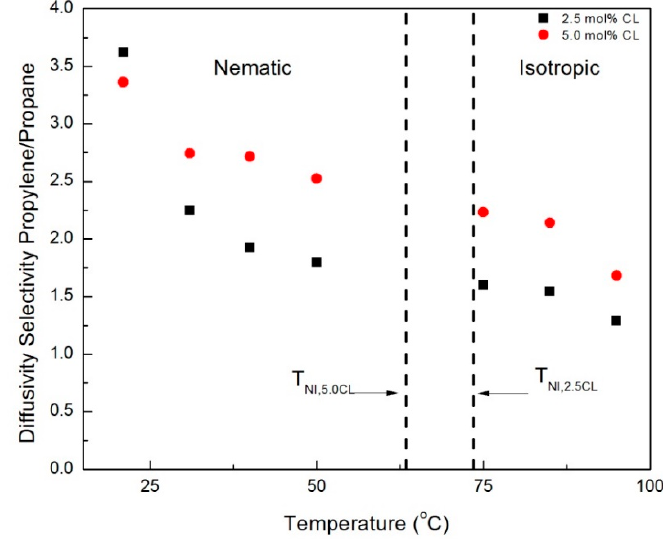
Figure 11. Propylene/propane diffusivity selectivities in the nematic and isotropic phases for membranes prepared with 2.5% and 5.0% crosslinker (CNBPh75_2.5 and